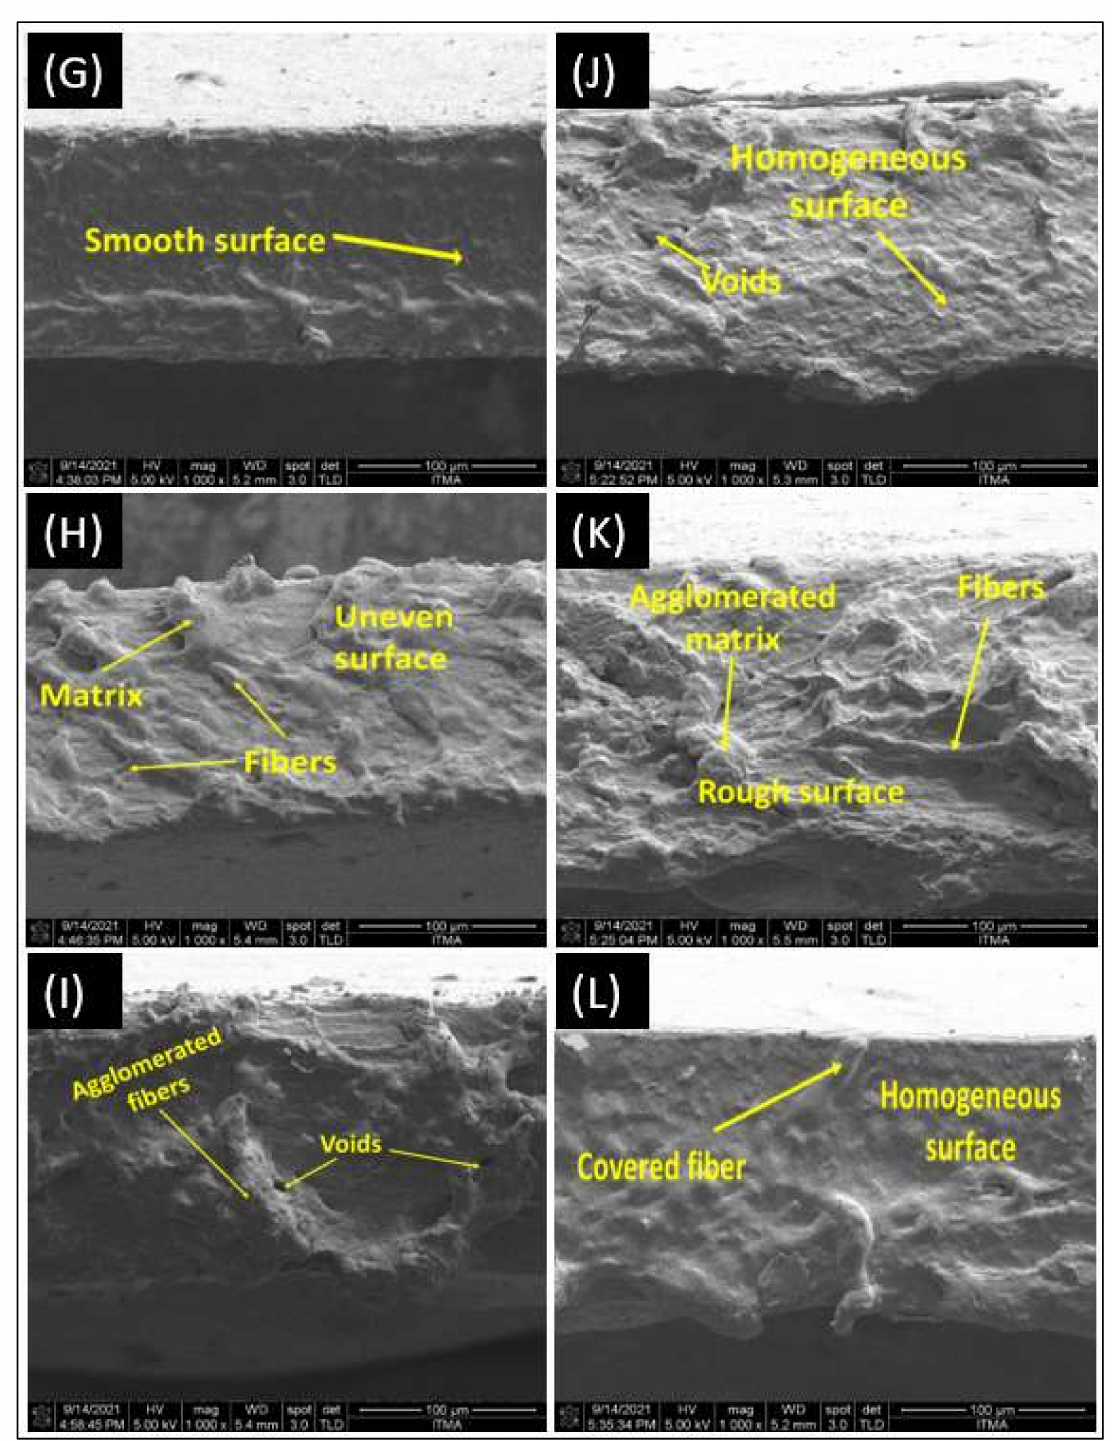
Figure 4. FESEM micrograph of surfaces ( A – F ) and cross-section ( G – L ) of control and TPAS/AF composites (2%, 4%, 6%, 8% and 10%),